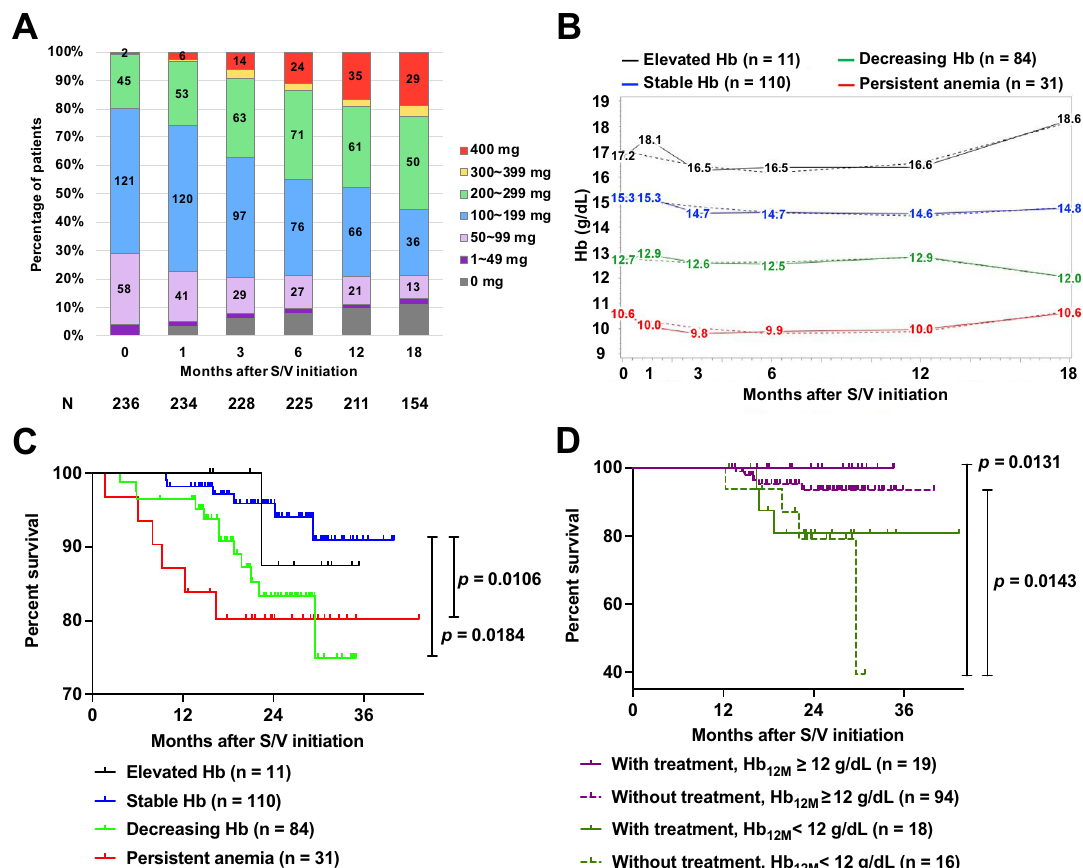
Figure 4. Trajectories for sacubitril–valsartan dose and Hb patterns, and Kaplan–Meier survival curves for groups in the anemia treatment analysis. For the anemia treatment analysis, we collected data from the EMR for 236 S/V-using patients who had recorded renal function, LVEF, and Hb data at the initiation of S/V therapy (baseline). ( A ) The numbers within the bars indicate the number of patients receiving each dosage at different time points of the observation period. ( B ) Using the SAS procedure “PROC TRAJ”, we identified four distinct Hb patterns. ( C ) Kaplan–Meier survival analyses demonstrated that the patients with “decreasing Hb” had significantly lower survival rates than did those with “stable Hb.” ( D ) Twelve months after initiating S/V therapy, we grouped the patients by their Hb 12M values and whether they had been prescribed anemia treatments such as iron or folate. The patients without anemia treatment prescriptions and with Hb of < 12 g/dL had significantly lower survival rates than those with Hb of ≥ 12 g/dL. However, this trend was not evident among the patients with anemia treatment prescriptions. BUN: blood urea nitrogen; eGFR: estimated glomerular filtration rate; EMR: electronic medical records; Hb: hemoglobin; Hb 12M : hemoglobin levels at 12 months after S/V initiation; LVEF: left ventricular ejection fraction; S/V: